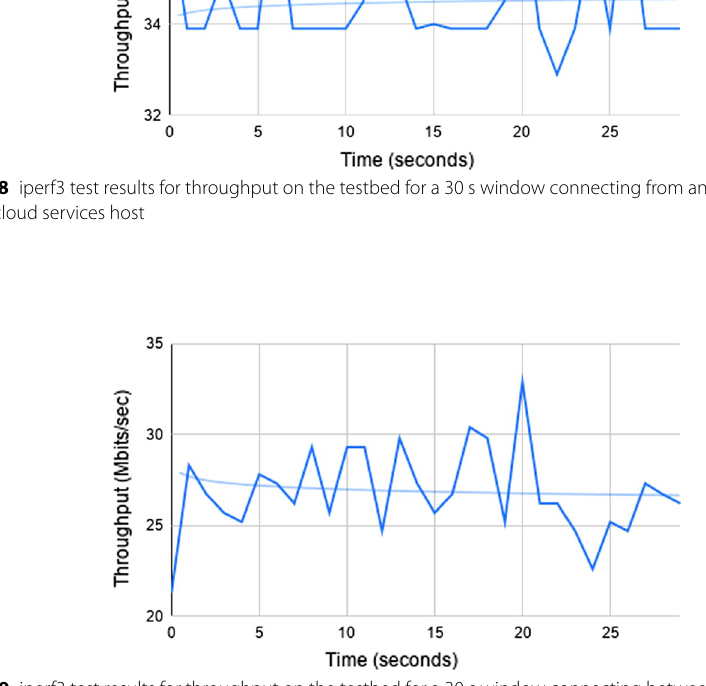
deviation in packet timeliness. With the base testbed configuration, this results in a